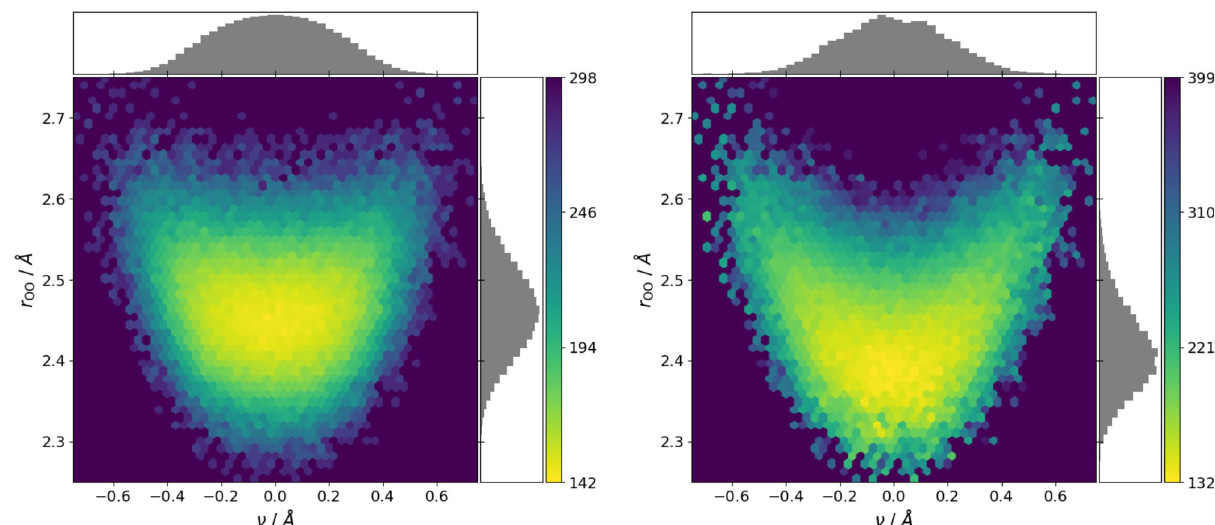
Fig. 4 Free-energy surfaces for the shared proton in a protonated water dimer. Left: original surface from the semiempirical molecular dynamics simulation. Right: resampled free-energy surface from the machine-learned coupled cluster functional. Histograms of the underlying distributions along both coordinates are also shown. Free energies are given in meV as a function of the proton reaction coordinate ( ν ) and the O – O distance ( r OO ). Note the different topology of the two surfaces discussed in the text, but also the largely different energy range obtained at the two levels of